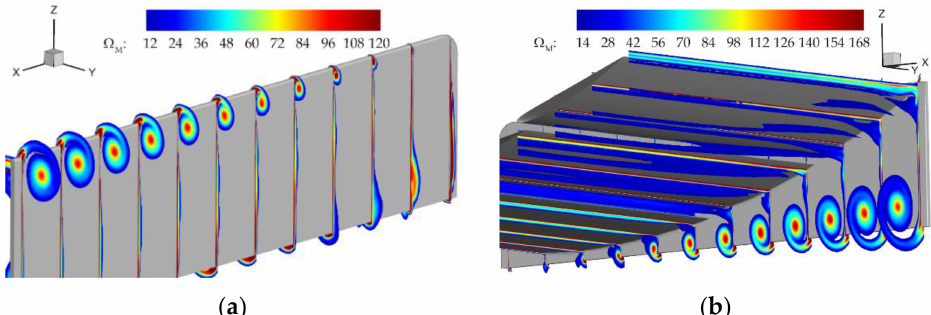
Figure 24. Contours showing the mean vorticity magnitude at several transverse locations ranging from x Wi /c = 0.0189 to x Wi /c = 1 under the straight-line condition. ( a ) Formation of Vortex A; ( b ) Formation of Vortex B.